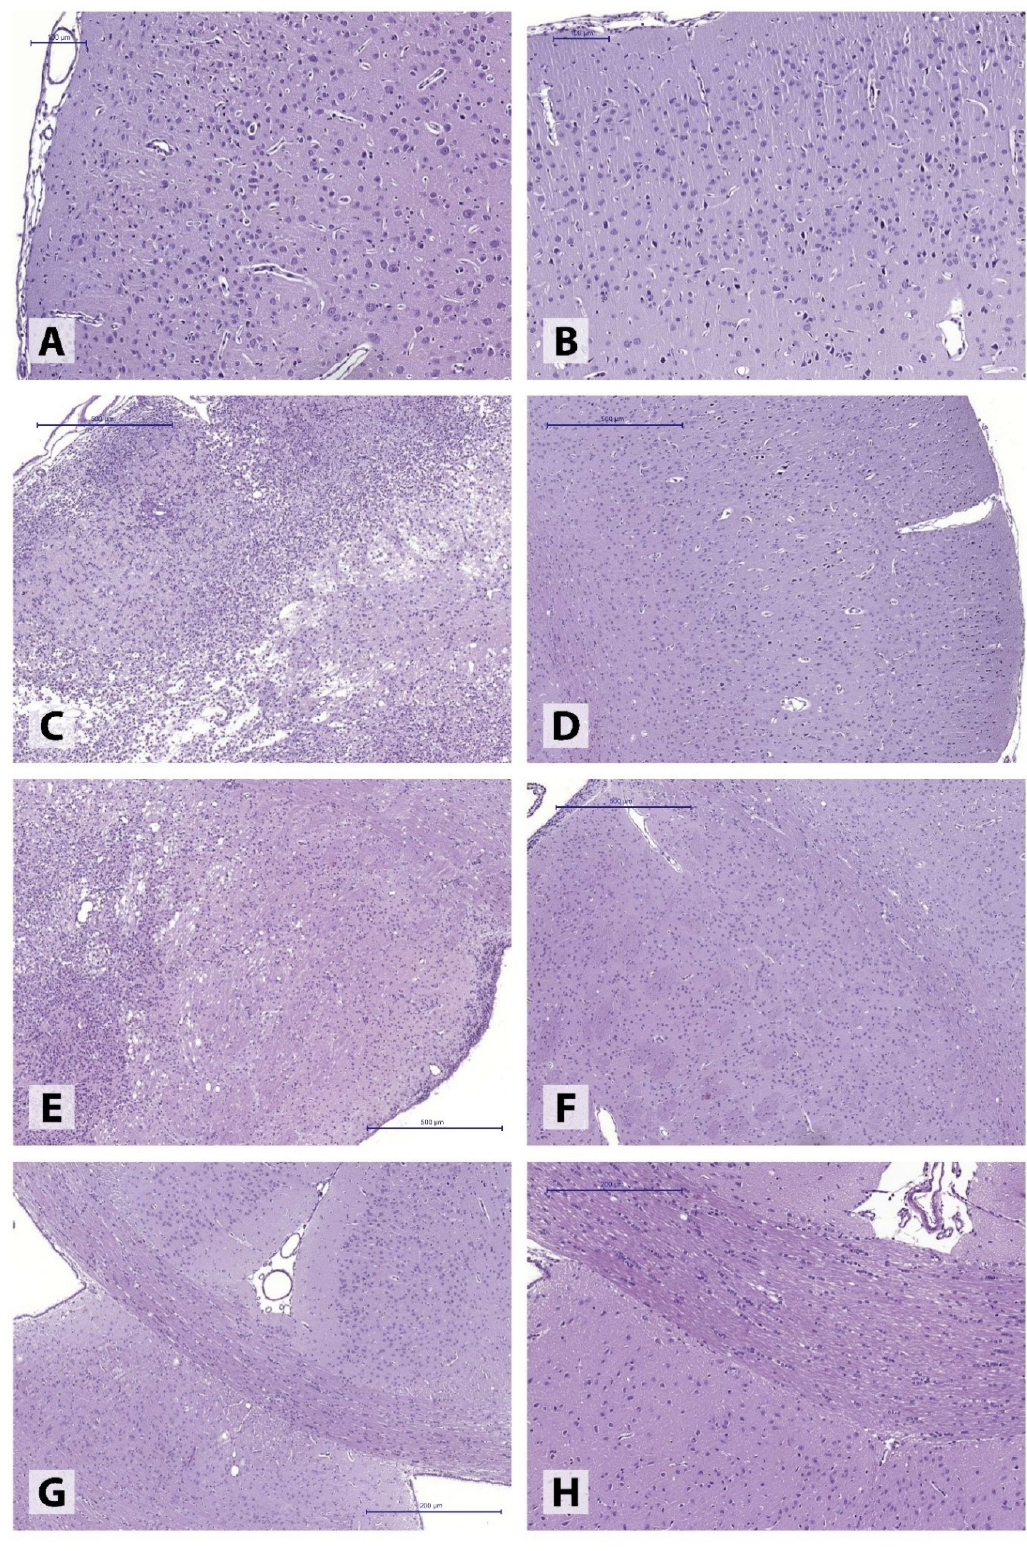
Figure 1. Histological features of different brain structures in experimental animals. ( A , B ) motor cortex (( A ), right hemisphere; ( B ), left hemisphere) in an IS 45 rat; ( C , D ) somatosensory cortex (( C ), right hemisphere; ( D ), left hemisphere) in an IS 45 rat; ( E , F ) striatum ( E ), right hemisphere, ( F ), left hemisphere in an IS 45 rat; ( G , H ) corpus callosum (( G ) in an IS 45 rat; ( H ) in a control rat). Haematoxylin and eosin